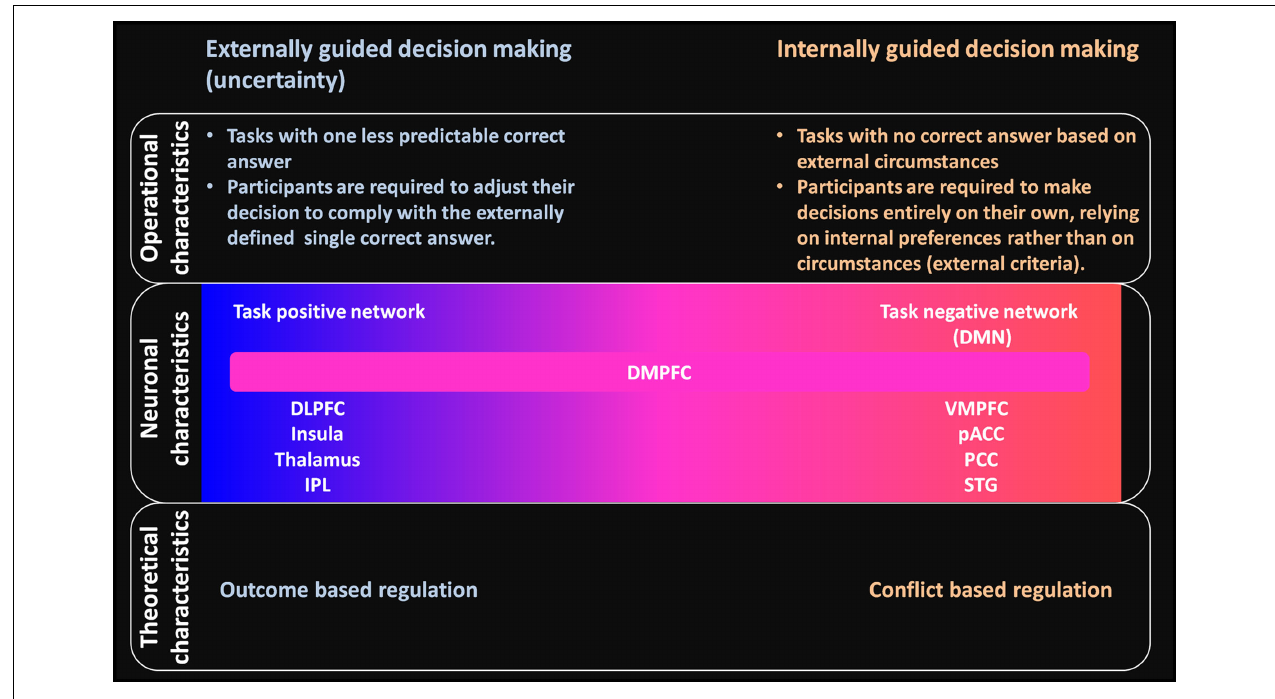
task-positive and task-negative networks. No clear boundary separates decision making processes of different kinds: each decision-making task can be located on the continuum.The extent to which the DLPFC–insula–thalamus–IPL or theVMPFC–pACC–PCC–STG networks becomes involved would differ depending on the decision-making situation. Theoretical characteristics: conflict-based regulation is expected to have an important role for internally guided decision-making instead of outcome-based regulation in the case of externally guided decision-making. The networks for internally guided decision-making are probably modulated according to the amount of conflict evaluated within